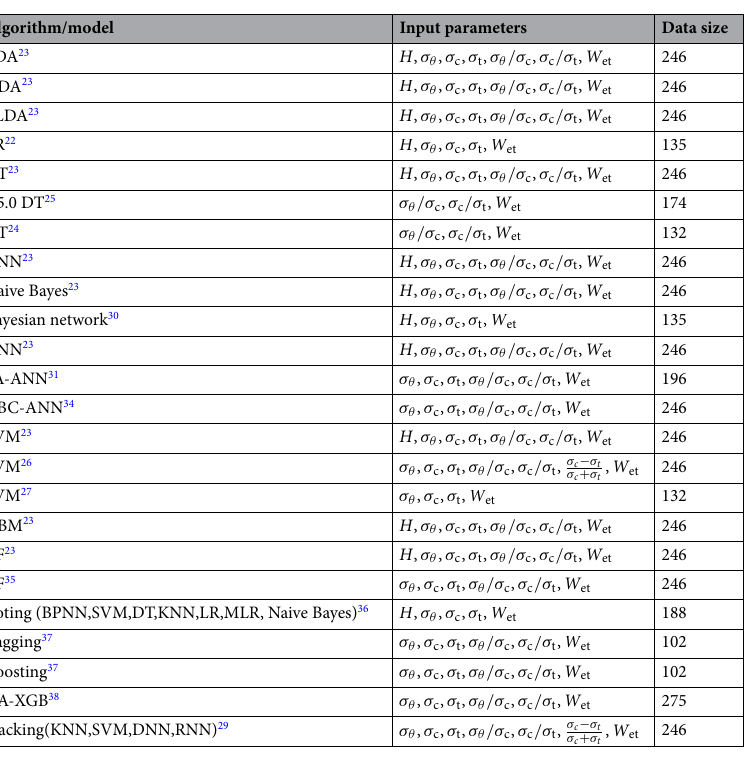
Table 1. Intelligent algorithms for predicting rockburst in recent years. LDA = linear discriminant analysis; H = depth; σ θ = maximum tangential stress; σ c = uniaxial compressive strength; σ t = uniaxial tensile strength; W et = the elastic strain index; QDA = quadratic discriminant analysis; PLDA = partial least-squares discriminant analysis; LR = logistic regression; DT = decision tree; KNN = k -nearest neighbor; ANN = artificial neural network; FA = firefly algorithm; ABC = artificial bee colony; SVM = support vector machine; BPNN = back propagation neural network; MLR = multiple linear regression; GA = genetical algorithm; XGB = extreme gradient boosting; DNN = deep neural network; RNN = recurrent neural